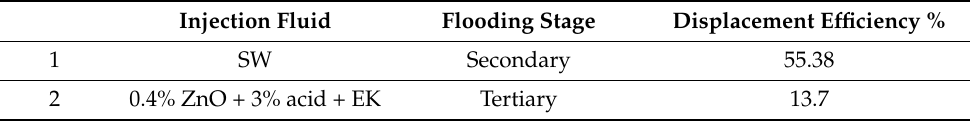
Table 14. Summary of